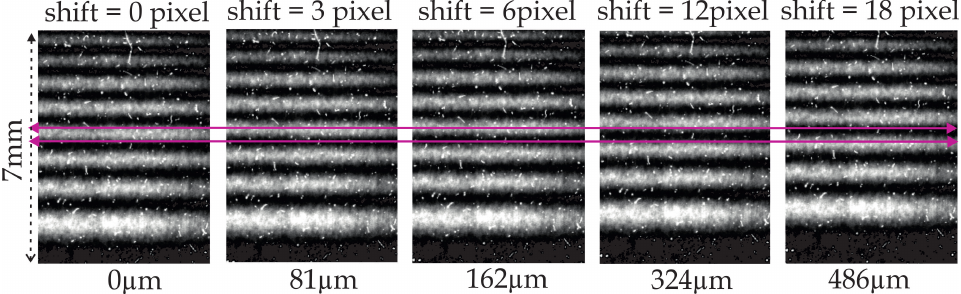
Figure 15. Five fringe pattern produced with of quadratic coil (from Figure 11, I = 3.5A) shifted by 3...18 pixel, pattern and fringes rotated by 90 ◦ , length of the coil = 150 mm, inner Al block = 11 mm × 11 mm, outer diameter = 35 mm, wire = Cu, (cid:11) = 0.90(1) mm, resistance = 1.2 Ω , 614 windings. If one plots two different shift positions of the fringe pattern, one obtains Figure